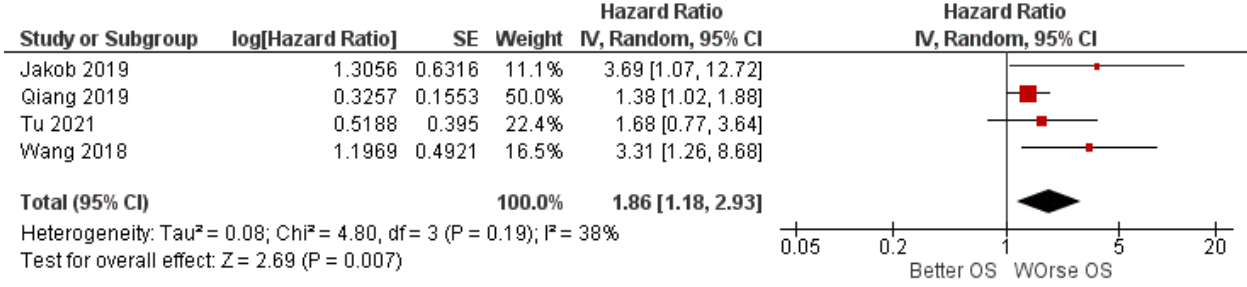
Figure 3. Funnel plot. The absence of heterogeneity is evident graphically. I 2 = 38%, SE: standard error.